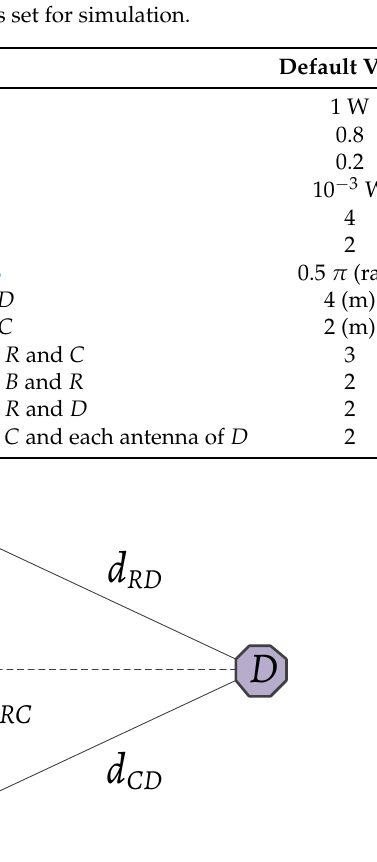
Figure 3. The simulation model, i.e., a parallelogram with R , B , C and D are its